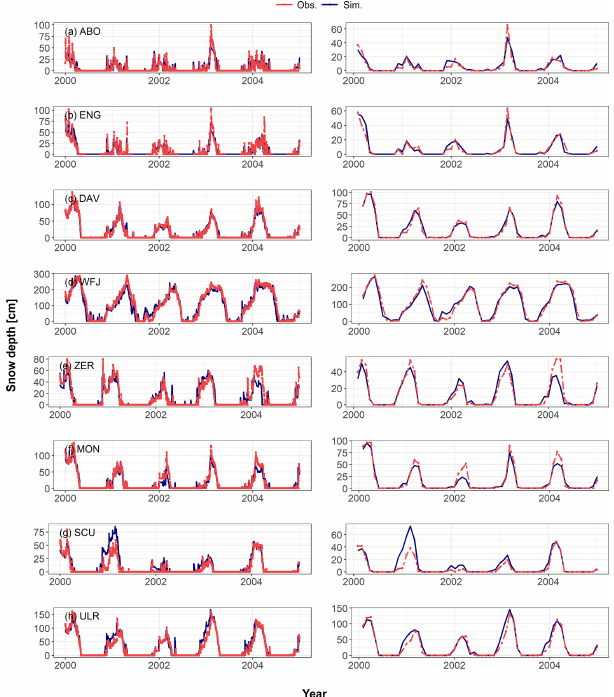
Figure 2. Validation results of SNOWPACK. Simulated daily (left) and monthly (right) mean snow depth driven by 3-hourly meteo- rological observations (sim) vs. measured daily and monthly mean snow depth (obs) for the period 2000 to 2004. See Table 1 for the abbreviations of case